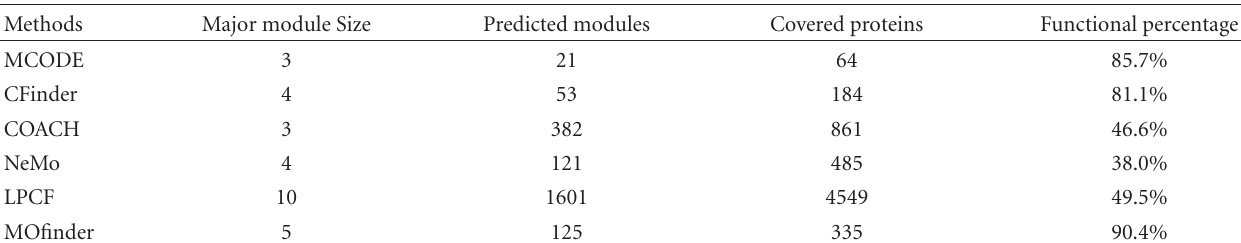
Table 1: Statistics for the major module size and other features when applied six methods to the yeast PPI